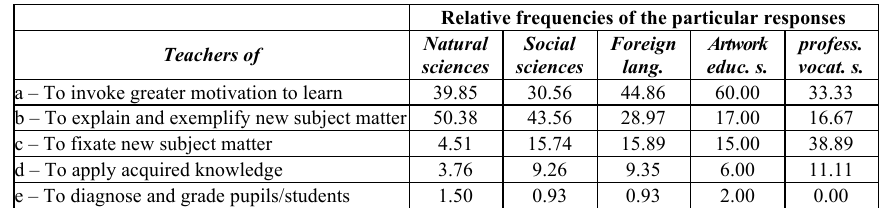
Table 4. Relative frequencies of the particular responses stated by different subject teachers (source: own